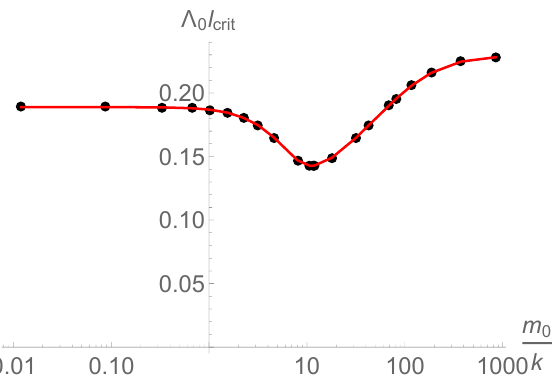
Figure 8. Characteristic length for AdS Q-solitons. This result is based on the set of solutions (the red solid line in (cid:12)gure 5) corresponding to the supersymmetric